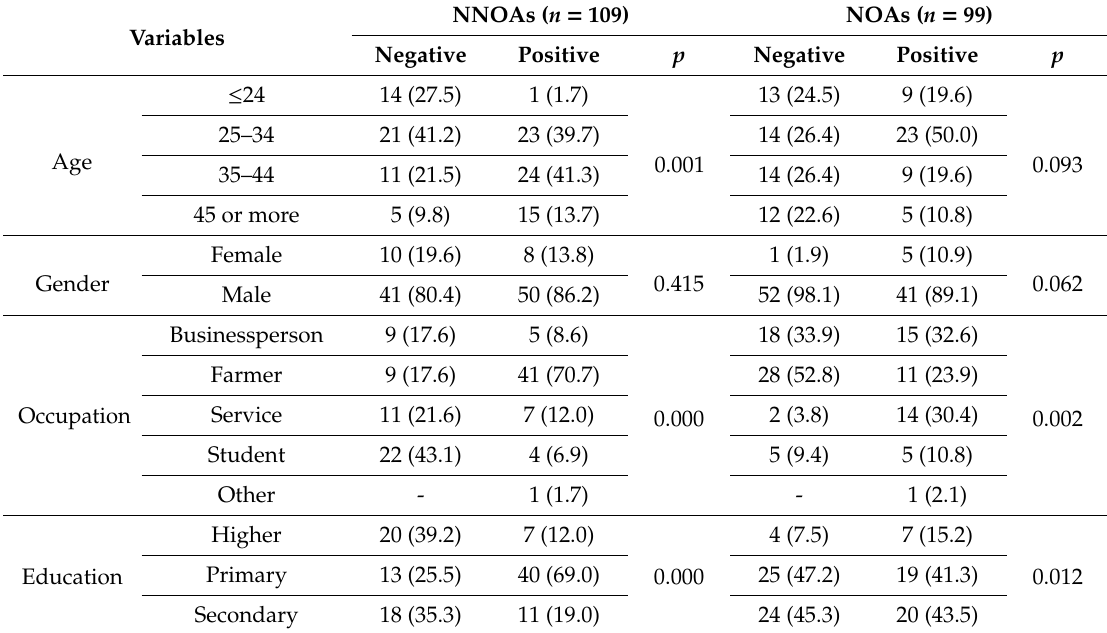
Table 6. Test of statistical significance of the variation in the respondents’ knowledge, attitudes, and perceptions of the spreading of NiV by their